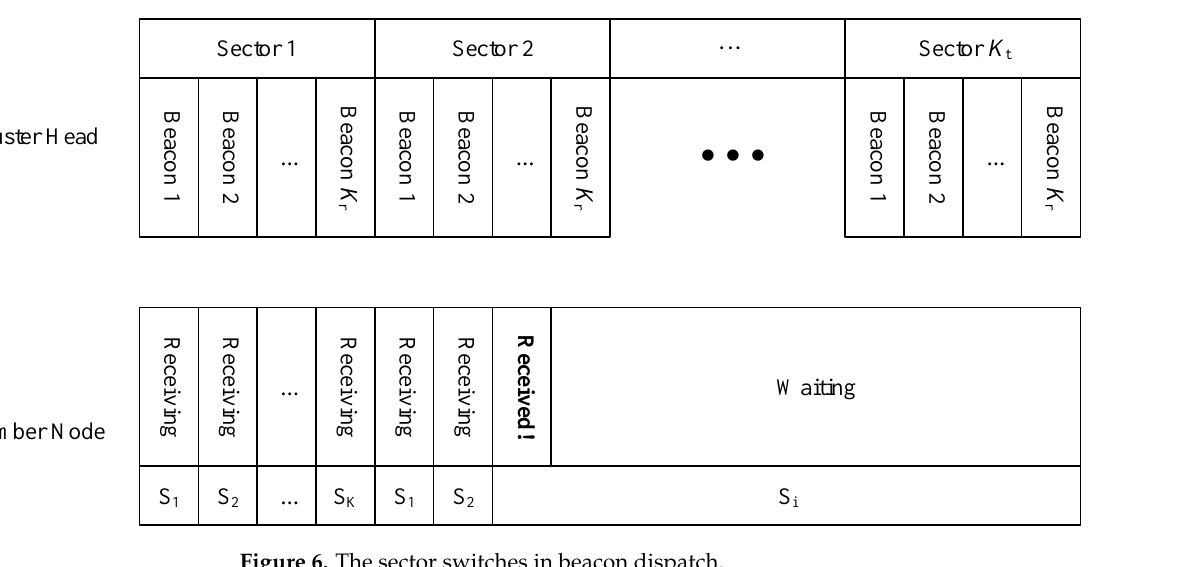
Figure 6. The sector switches in beacon dispatch.